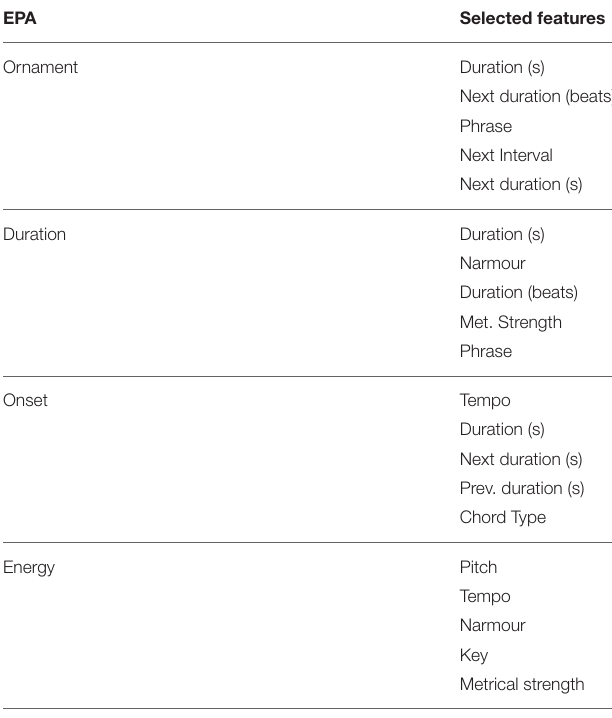
TABLE 6 | Most relevant features for each performance action obtained by both filter and wrapper feature selection.